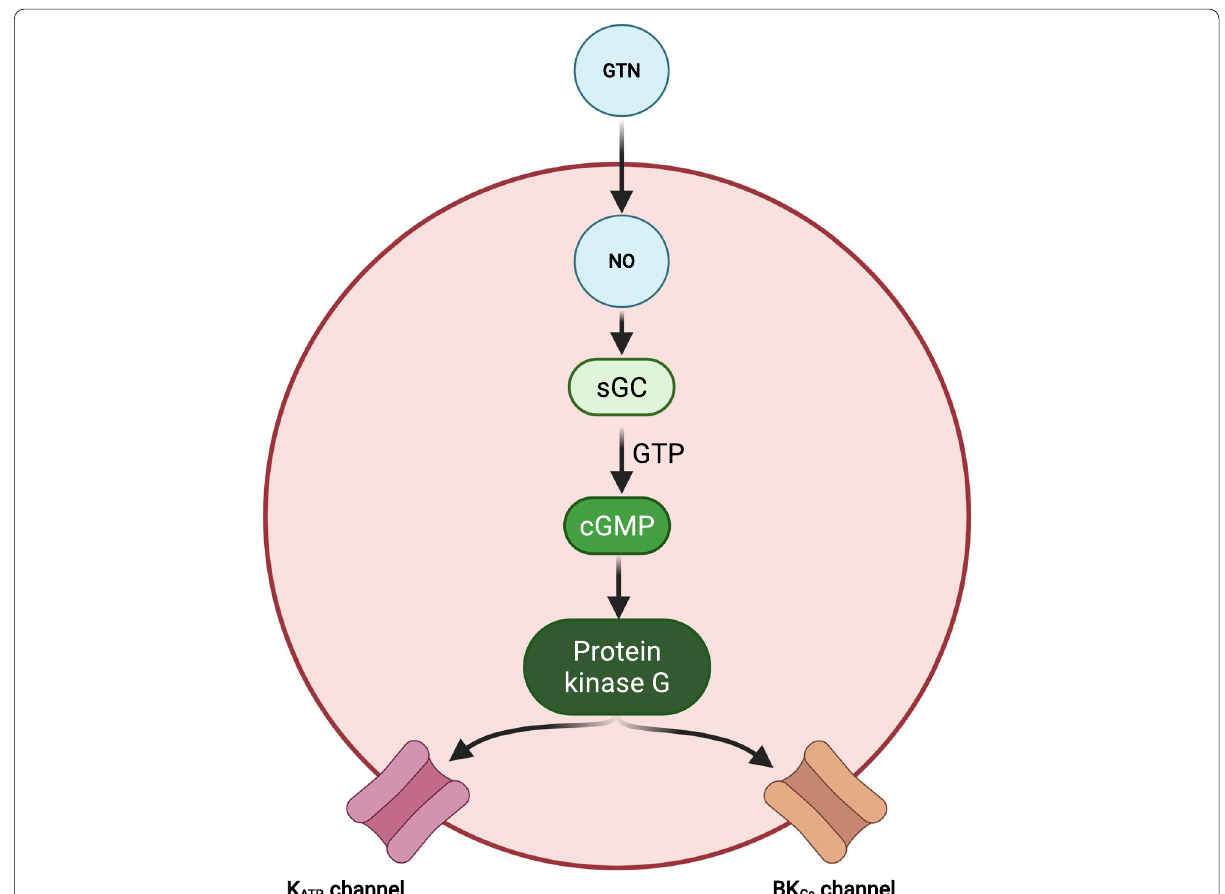
Fig. 2 cGMP-dependent pathways in migraine pathophysiology. In vascular smooth muscle cells of the intracranial arteries, nitric oxide (NO) from glyceryl trinitrate (GTN) increases levels of cyclic guanosine monophosphate (cGMP). This activates the cGMP-dependent protein kinase (protein kinase G) which increases opening of adenosine triphosphate-sensitive potassium (K ATP ) channels and large conductance calcium-activated potassium (BK Ca ) channels. It will similar to the cAMP-dependent pathway ultimately activate and sensitize perivascular trigeminal afferents (see Fig. 1) [2]. BK CA , large conductance calcium-activated potassium channels; cGMP, cyclic guanosine monophosphate; GTN, glyceryl trinitrate; GTP, guanosine triphosphate; K ATP -channels, adenosine triphosphate-sensitive potassium channels; NO, nitric oxide; Protein kinase G, cGMP-dependent protein kinase; sGC, soluble guanylate